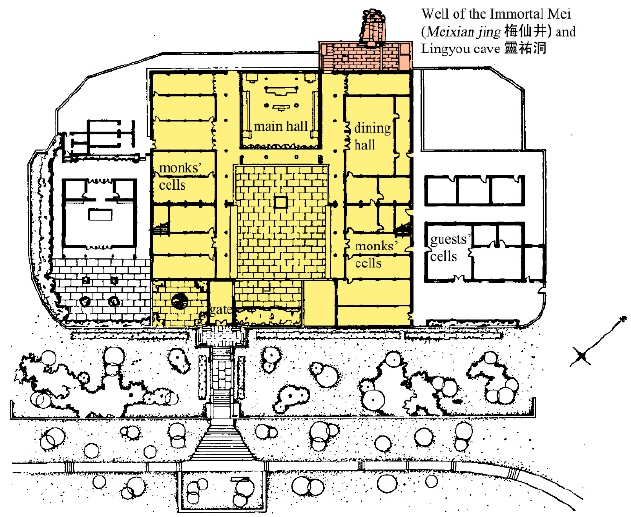
Figure 4. Plan of the Well of the Immortal Mei and the Temple of the Immortal Mei (Zhao and Ding 1997, p. 275).